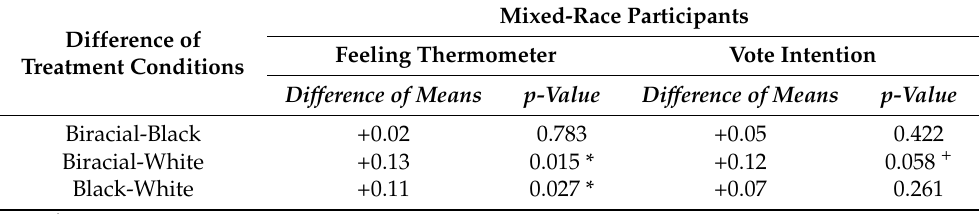
Note: + p < 0.1; * p < 0.05; ** p < 0.01; *** p <